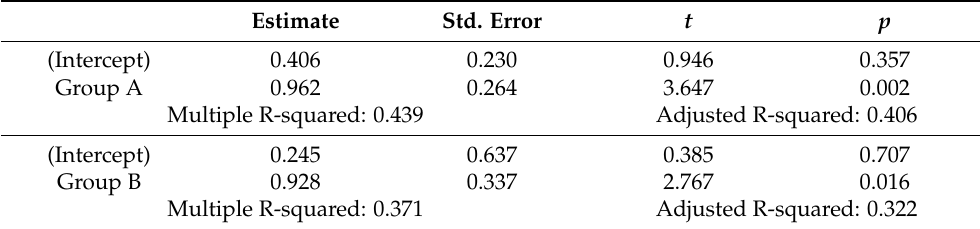
Figure 4. Linear model for VEGF (post dependence on pre). The lines indicate the predicted trend of changes of “pre” and of “post” values (red for group A and green for group B). The dashed grey line is the set of points for which the pre and post values are identical. Points for group A were marked in red, while points for group B were marked in green. Abbreviation: VEGF—vascular endothelial growth factor. Table 4. Linear model for VEGF. Table 5. Linear Model for